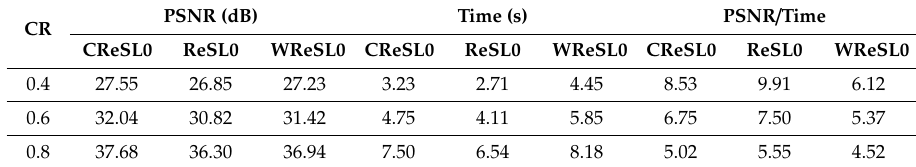
Table 2. The PSNR, time and PSNR / time of each algorithm for di ff erent compression ratios. PSNR CR